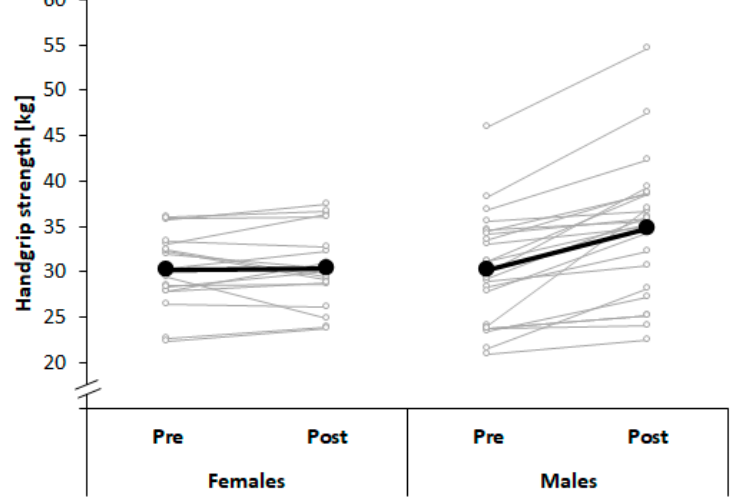
Figure 4. Changes in handgrip strength across a period of 10 months of judo training in young male and female judo athletes.